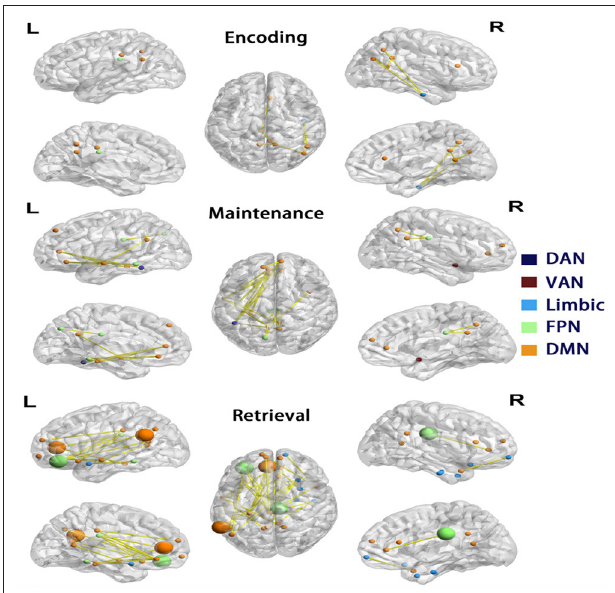
FIGURE 4 | Differences in functional connectivity of Network 1. Each row showed nodes with significantly reduced connectivity in AD compared to controls in each phase, visualized by BrainNet Viewer ( Xia et al., 2013). The nodes are colored by the a priori network assignments in the Schaefer atlas. Larger sized nodes indicate significant decreased functional entropy in the AD, as well as decreased functional connectivity. DMN, default mode network; FPN, frontoparietal network; DAN, dorsal attention network; VAN, ventral attention network.